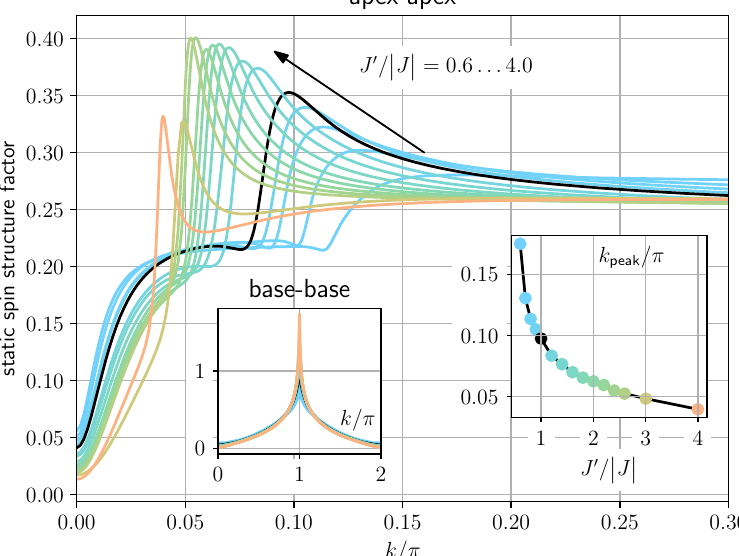
Figure 9: Static apex-apex spin-structure factor for the infinite system with the U(1) spin symmetry exploited (Eqs. (10) and (13) with α = β = A ). The right inset shows the position of the peak as a function of J ′ / plot. The left inset shows the corresponding base-base structure factor ( α = β = B